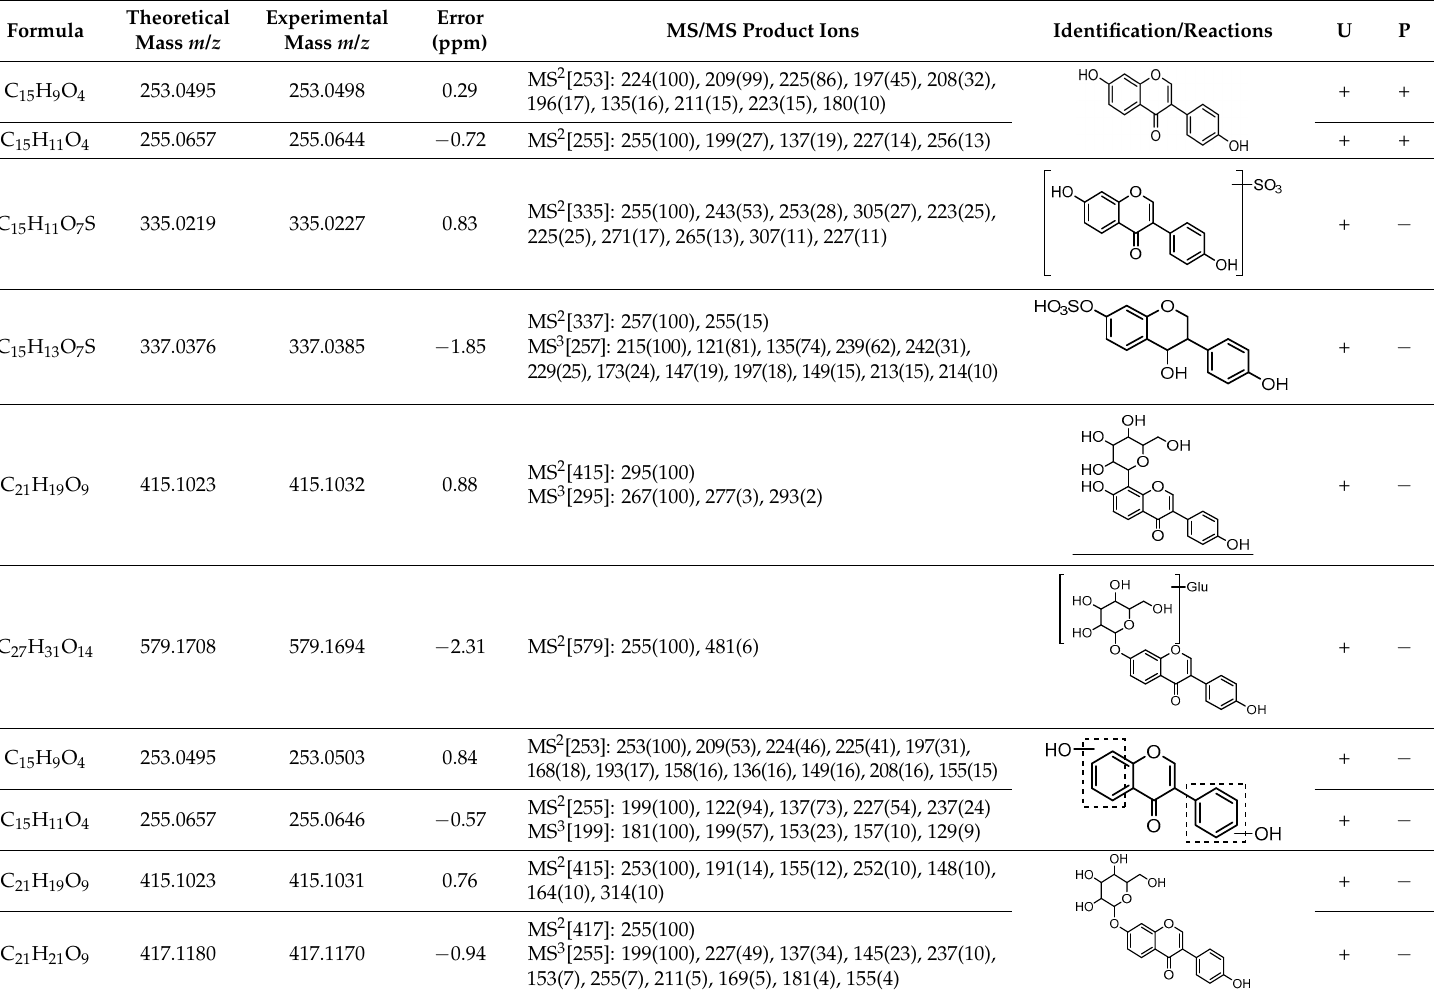
Table 1. Summary of daidzein metabolites in rat urine and plasma.